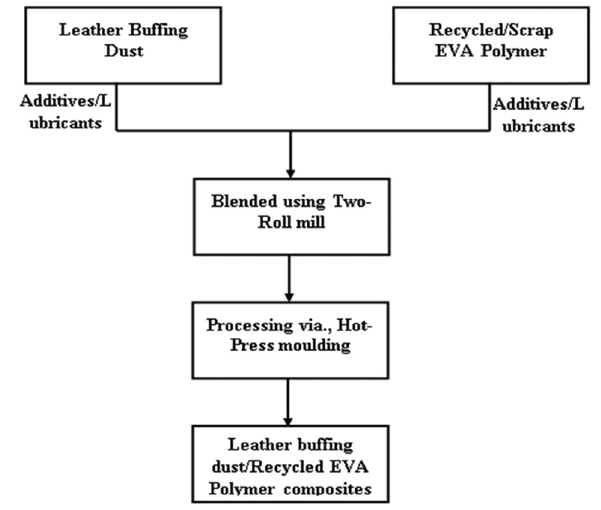
Figure 4: Flow chart representing the processing of solid leather wastes/recycled EVA thermoplastic elastomer polymer composites.